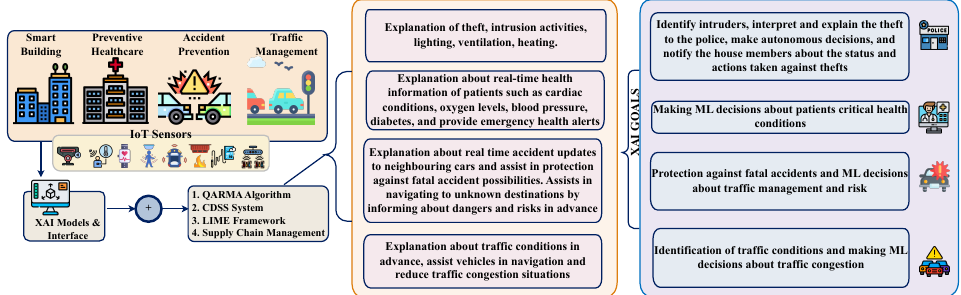
Figure 4. A use case of XAI with IoT for Smart